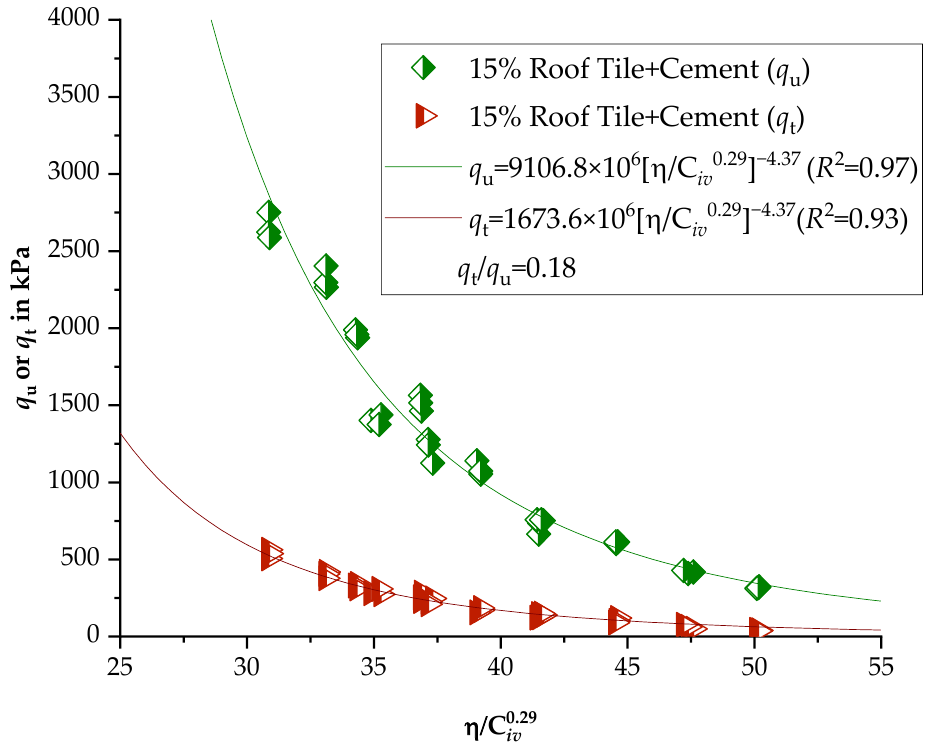
Figure 3. Variation of q u and q t with the porosity/volumetric cement ratio (using the exponent b = 0.29) for 15% of roof tile waste.